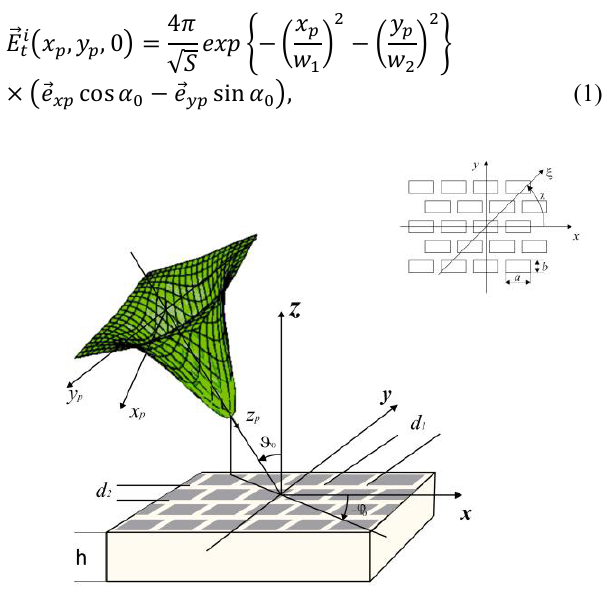
Figure 1: Gaussian beam incidence on a double-periodic structure.